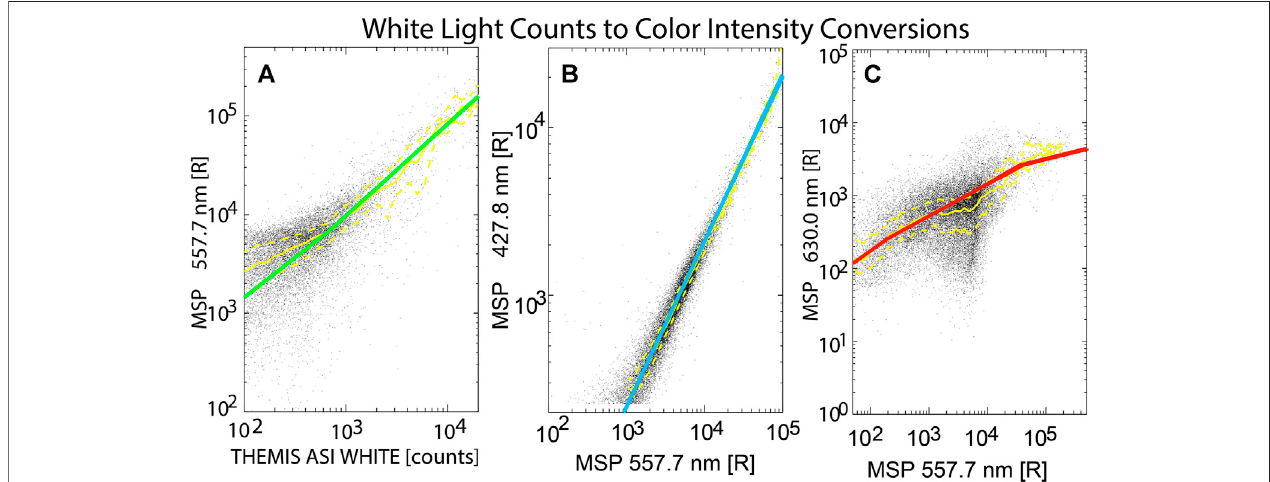
FIGURE 3 | (A) Scatter plot of green light intensity vs. white light counts from 07:00 – 10:00 UT. Solid yellow line shows median whereas dashed yellow lines show quartiles of green intensity for a given white light bin 50 counts wide. The green line represents the functional fi t. (B) Scatter plot of blue light intensity vs. green light intensity. Solid yellow line shows median whereas dashed yellow lines show quartiles of blue intensity for a given green light bin 50 R wide. Blue line represents the functional fi t. (C) Scatterplotofredlightintensityvs.greenlightintensity.Solidyellowlineshowsmedianwhereasdashedyellowlinesshowquartilesofredintensity for a given green light bin 50 R wide. Red line represents the functional fi